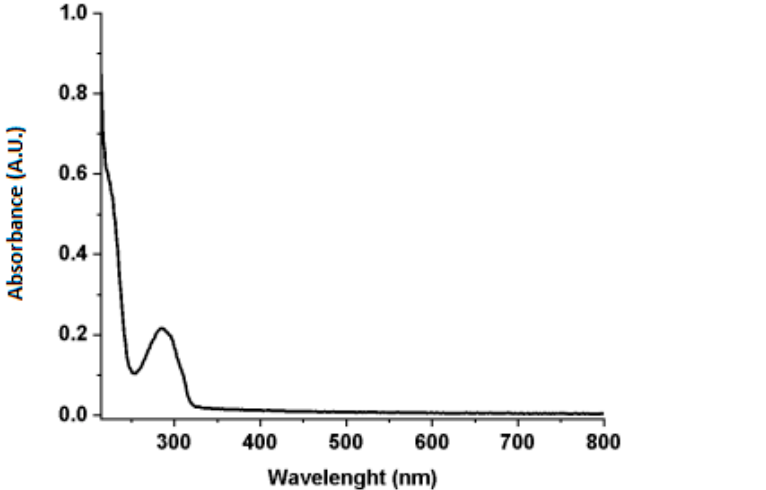
Figure 2. UV/Vis absorption spectrum of green coffee oil diluted in ethanol. The analysis was performed in triplicate (n = 3).